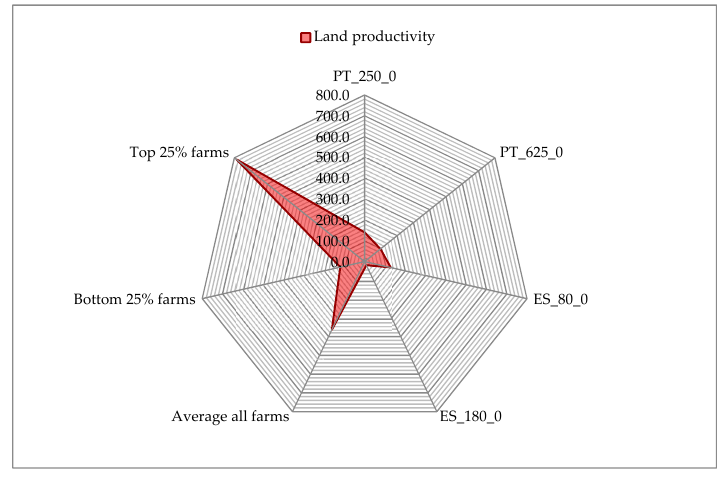
/ ha). Source: model Figure 17. Land (kg LW/ha). Source: model results. Figure 17. Land (kg LW/ha). Source: model results. Figure 17. Land (kg LW